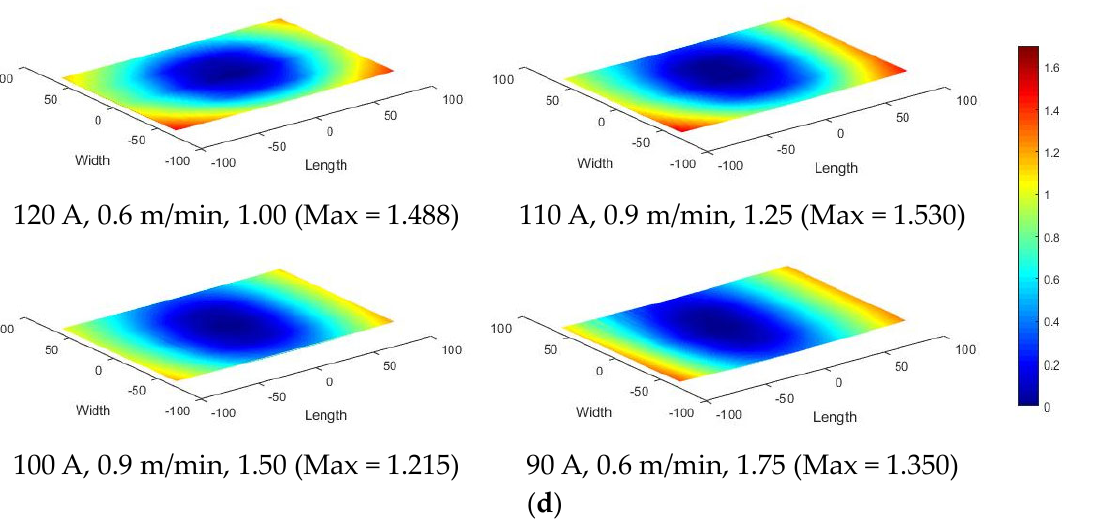
Figure 7. Distortion plots for various experiments with passive thermal management. ( a ) Natural cooling and continuous deposition. ( b ) Natural cooling and delay deposition. ( c ) Forced cooling and continuous deposition. ( d ) Forced cooling and delay deposition.